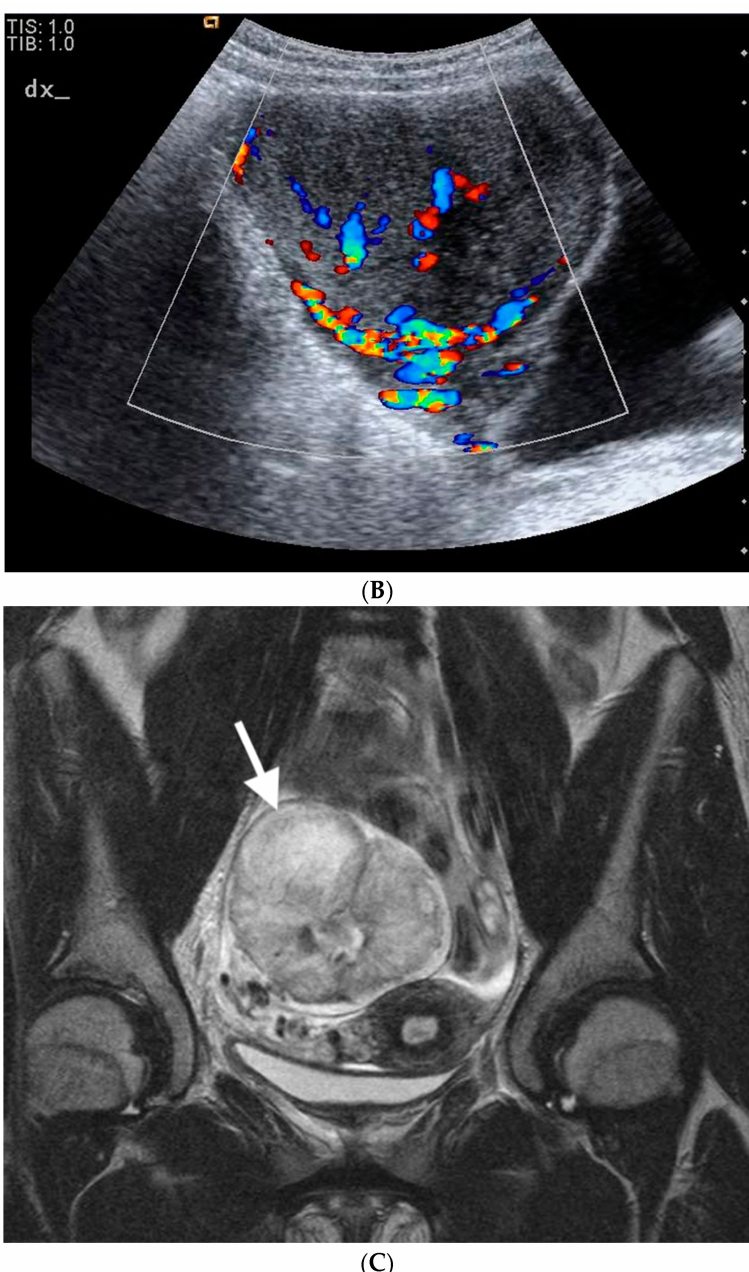
Figure 1. ( A ) Ultrasound image reveals a solid mass with focal hypoechoic components, possibly due to necrosis; ( B ) Doppler US image reveals prominent peripheral vasculature; ( C ) MR images show an uneven expansive mass in the right paramedian pelvic region, which dislocates the uterus. The arrow indicates the formation found on the